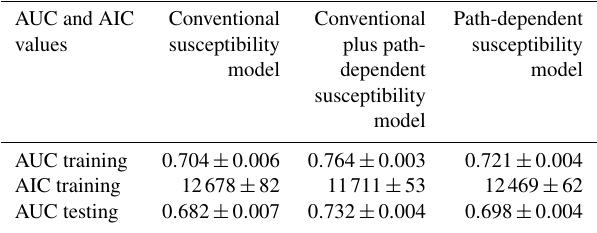
Figure 6. Space–time dynamic of landslide path dependency. The colours represent the intensity of STC measure. Red indicates high STC, and green indicates low STC. Table 1. Performance of the three landslide susceptibility mod- els. The values of AUC represent the average AUC values in the 10 training and 10 testing datasets. The values of AIC represent the average AIC values in the 10 training